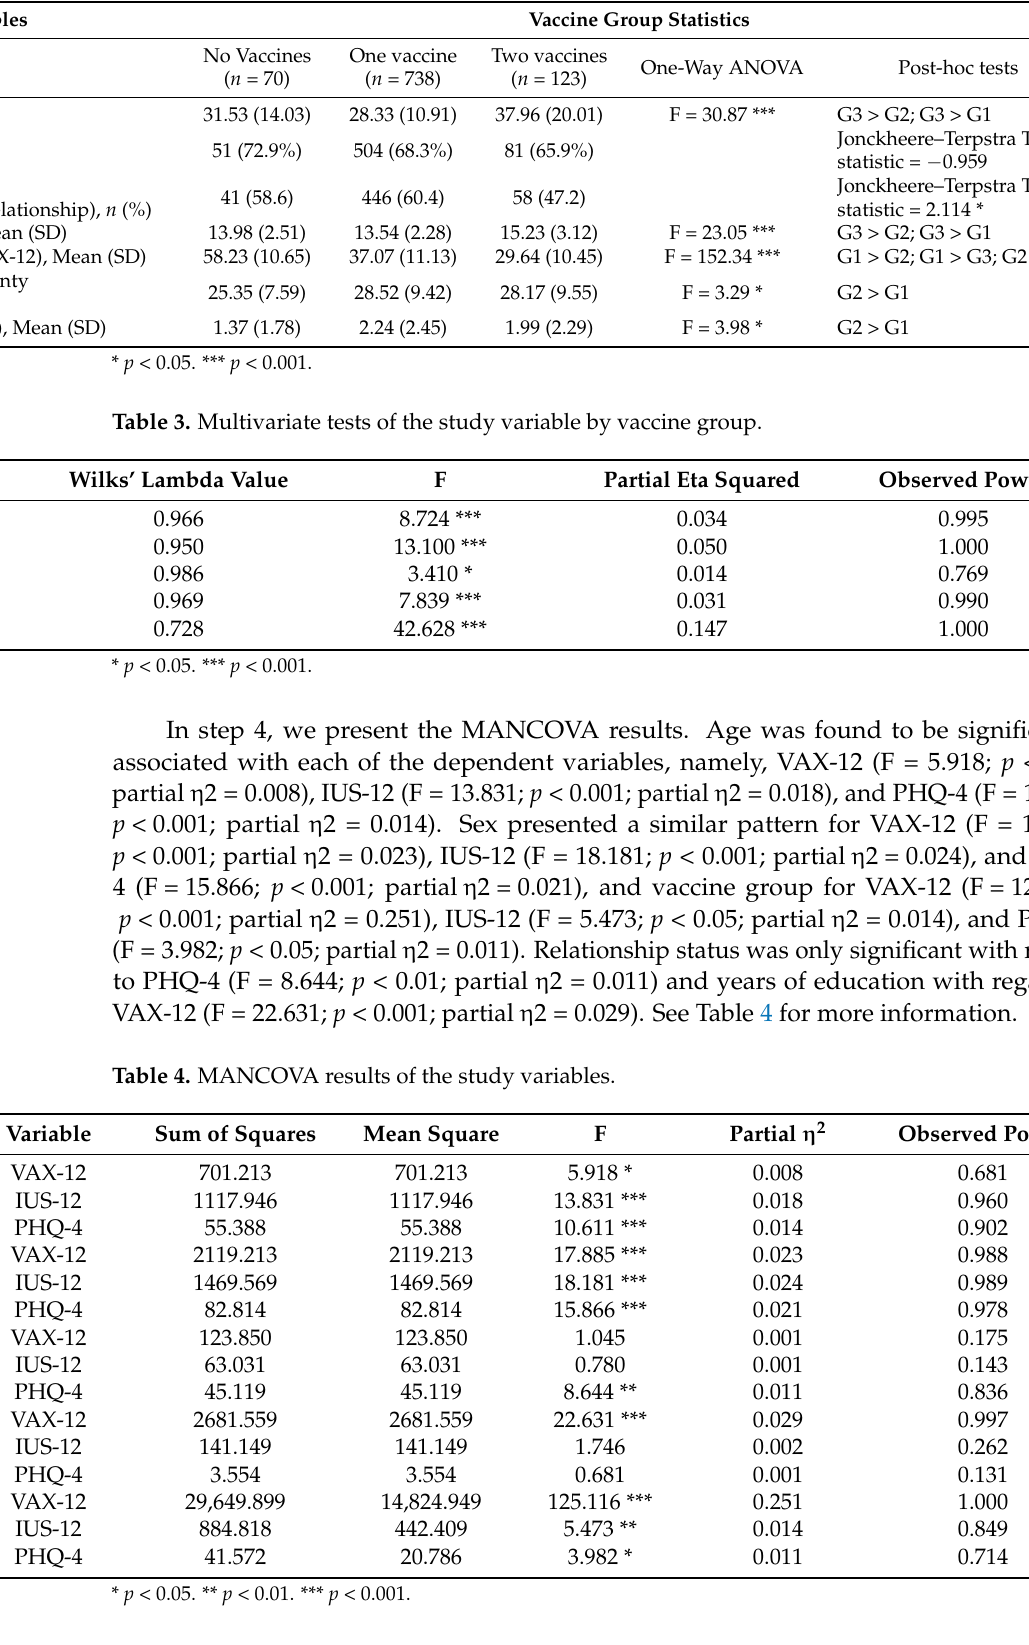
Table 2. One-way ANOVA of the study variable by vaccine group.